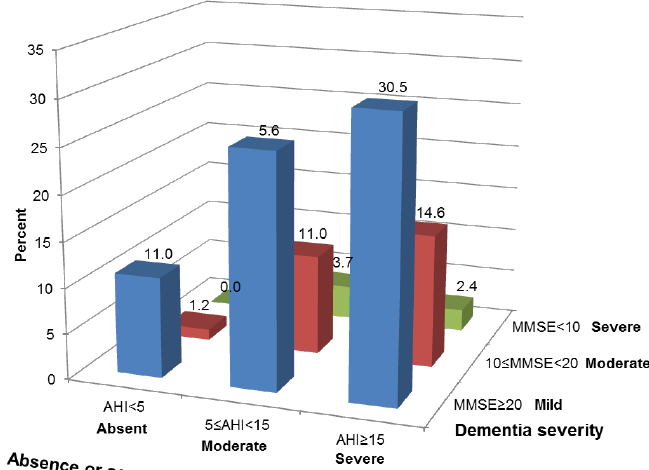
Figure 1. Association between severity of sleep-disordered breathing and severity of dementia. Chi-square test revealed no significant association χ 2 (4) = 3.33, p = 0.521, Cramer‘s V = 0.14. MMSE = Mini-Mental state examination.